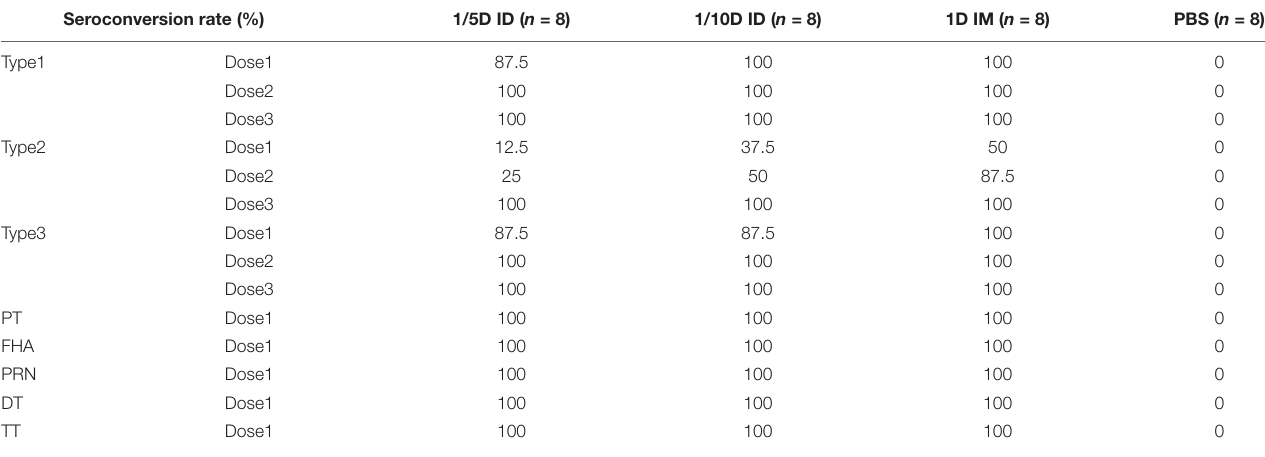
TABLE 2 | Seroconversion rates against types 1, 2, and 3 poliovirus strains, and PT, FHA, PRN, DT, and TT after vaccinations. Seroconversion rate